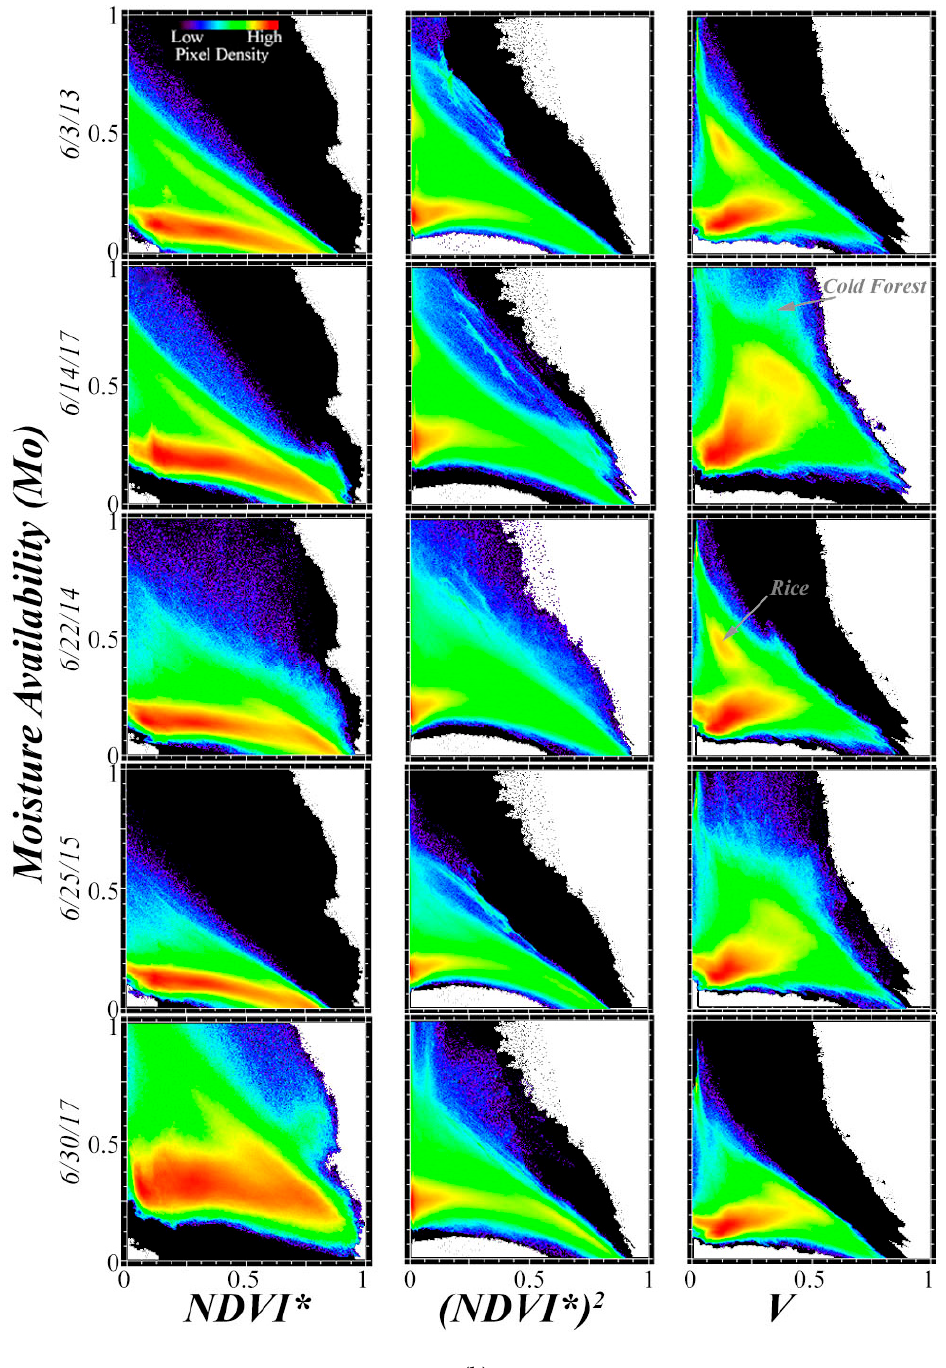
Figure 3. ( a ) Vegetation metrics vs EF . Regions with high vegetation cover collapse into a tight range of EF . Regions with low vegetation can have high or low EF . For images earlier in June, the abundance of flooded rice paddies results in a cluster at high EF but low T . This cluster migrates to higher V later in June as the rice canopy fills. Again, NDVI* shows the least structure, NDVI* 2 is intermediate, and V shows the most structure. ( b ) Vegetation metrics vs Mo. Regions with high vegetation cover converge into a tight range of low Mo . Regions with low cover can have high or low Mo . In some scenes, forests at higher elevation in the NE corner of the image are colder than that rest of the image and so record anomalously high Mo . With V , the rice paddy cluster is again separate in early June, then moves to high V and low Mo values as the canopy fills. This cluster is barely distinguishable, and the structure much less clear, using either spectral